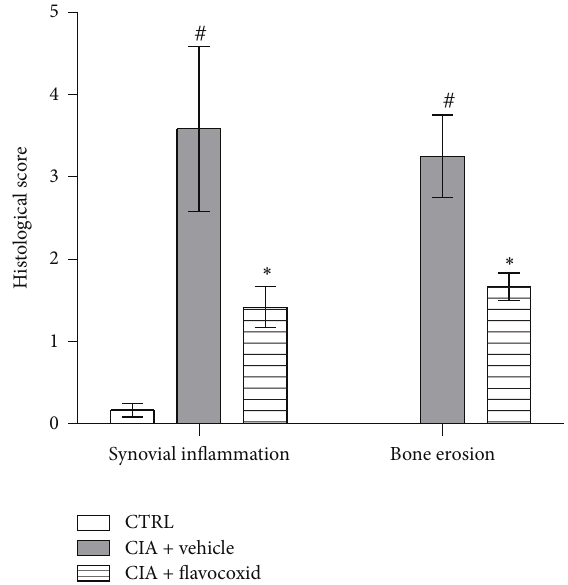
Figure3:Effectsofflavocoxidinacollagen-inducedarthritismodel. # 𝑃 < 0.001 versus ctrl; ∗ 𝑃 < 0.005 versus CIA +